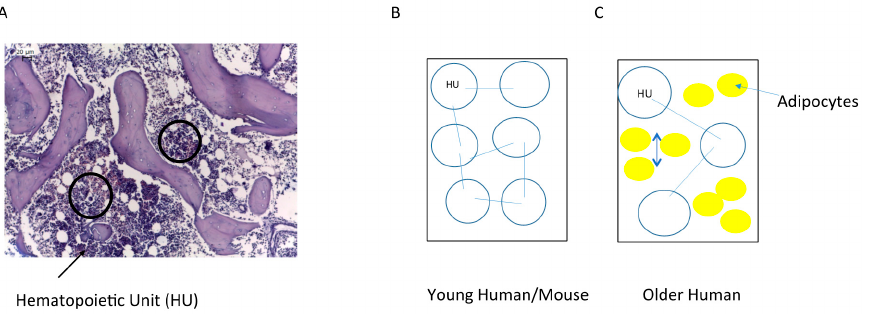
Figure 6. Hematopoietic Unit (HU) model. ( A ) The topobiology of the bone marrow in both mice and humans is composed of several HUs; ( B ) In young humans and mice, the HUs are abundant and have physical contact in the context of highly cellular bone marrow; ( C ) In older humans, the HUs are less abundant and may be separated by adipocytes. Each HU is highly vascularized, and HUs may interact with each other via the vasculature and/or perivascular mesenchymal stromal/stem cells